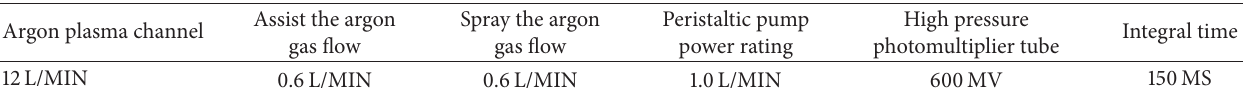
Table 3: Analysis of metal concentration